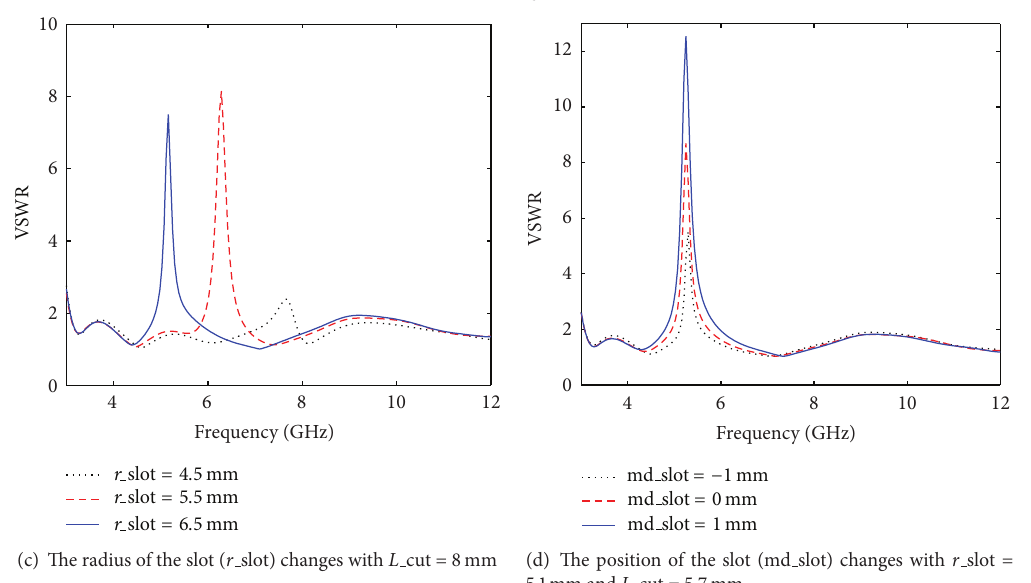
the restriction of the patch size and the coupling between the nearby slots, a U-shape, slot instead of the C-shape, slot is further added for reducing the coupling with other slots. The optimized parameters of the antenna geometry are listed in Table 1. For convenience, the reference point is considered to be the top left corner.